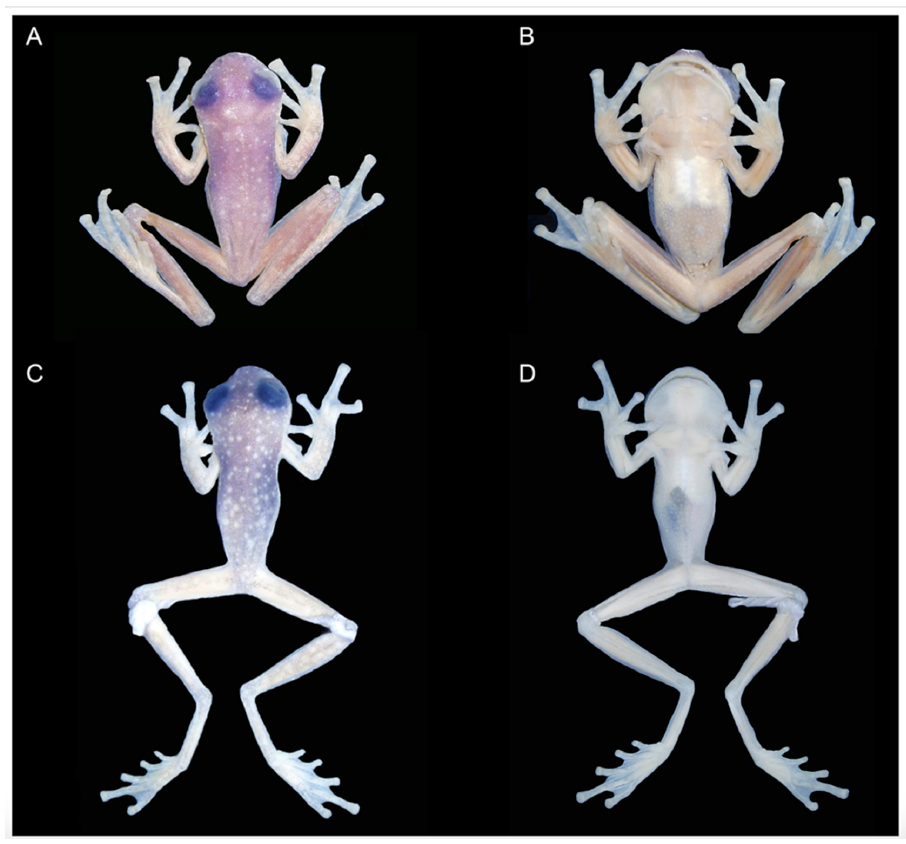
Figure 59. Types of Centrolene sanchezi and C . bacata in preservative. ( A , B ) Centrolene bacata , holotype KU 202803. ( C , D ) C . sanchezi , paratype ICN 24294. Photos by Juan M.